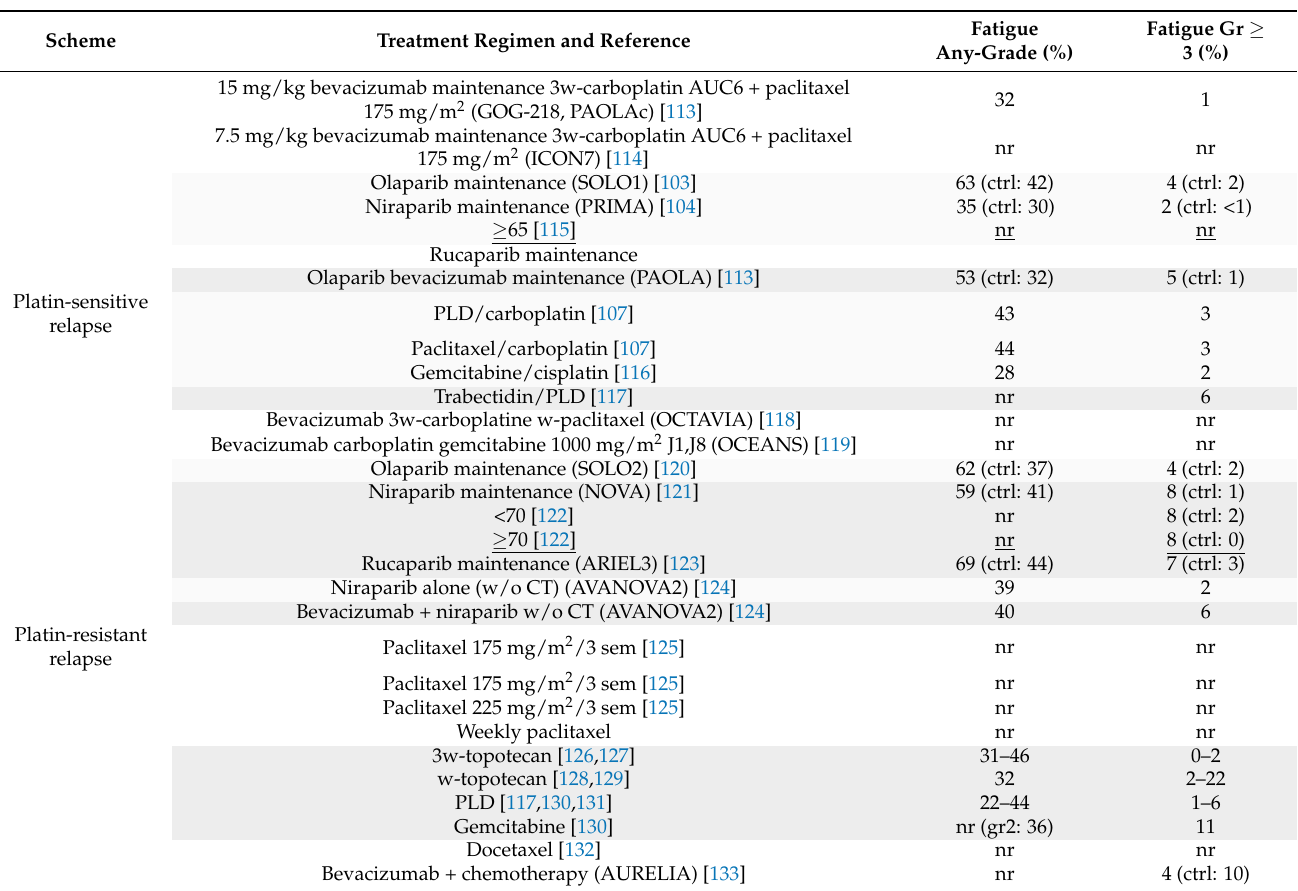
The colors refer to the hiher reported freuency of grade 3 or more fatiue for each